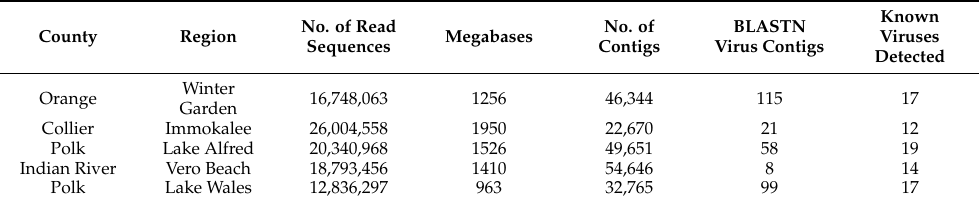
Table 2. Statistics for D. citri RNA-seq assemblies from five regions in Florida.